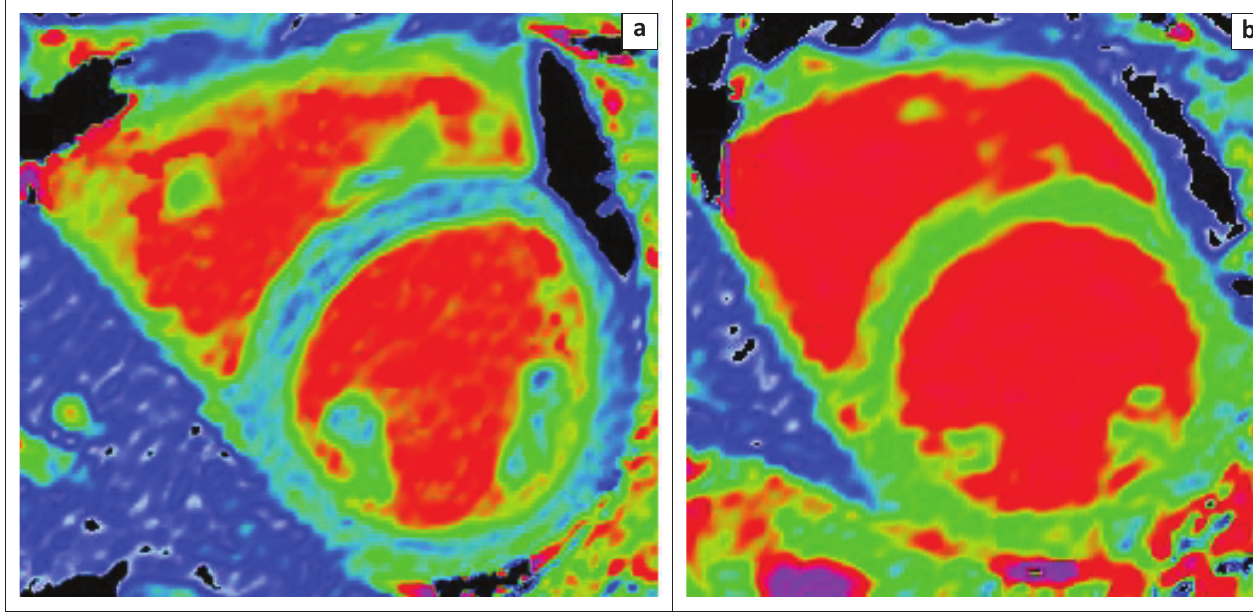
FIGURE 5: LGE (a), T1 map (b) and ECV map (c) in TTR amyloid. LGE image shows abnormal gadolinium kinetics (blood pool nulls ahead of myocardium) and T1 maps. T1 values are globally elevated, and heart muscle appears thickened. ECV maps show an ECV volume of 60 % .